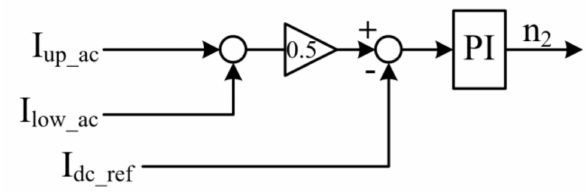
Figure 6. Arm current control.